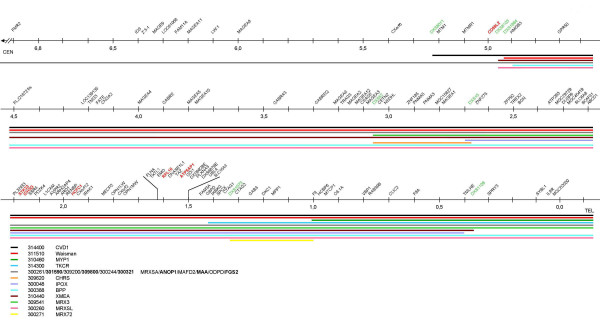
Xq28 map and disease regions. The Xq28 region is shown in a megabase scale and regions of Xq28-mapped diseases are shown as different colored lines. Candidate genes discussed in the text are shown in red. Genetic markers are shown in green.